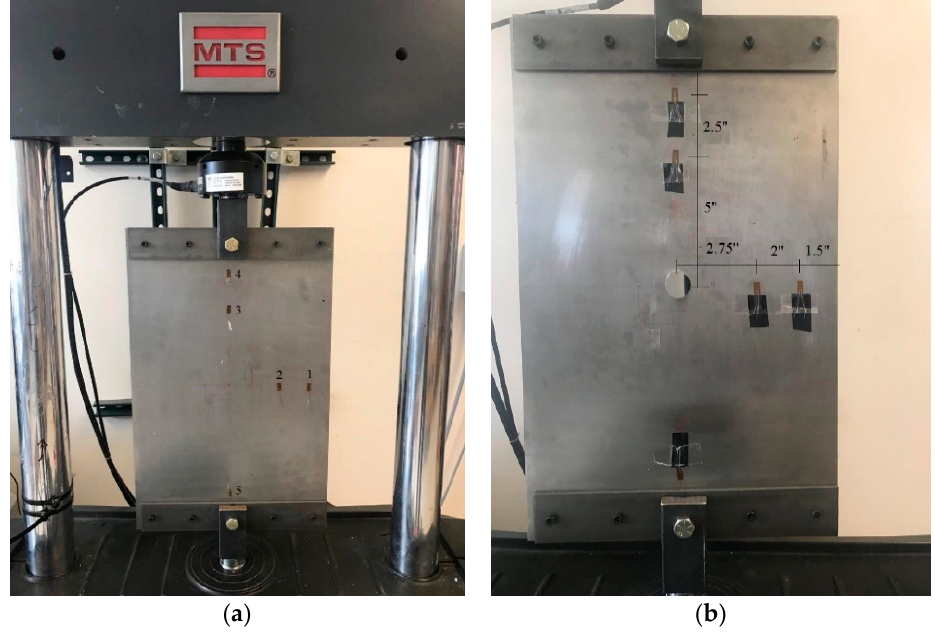
Figure 2. Test setup and strain gauge locations. ( a ) Intact plate and ( b ) Damaged plate.